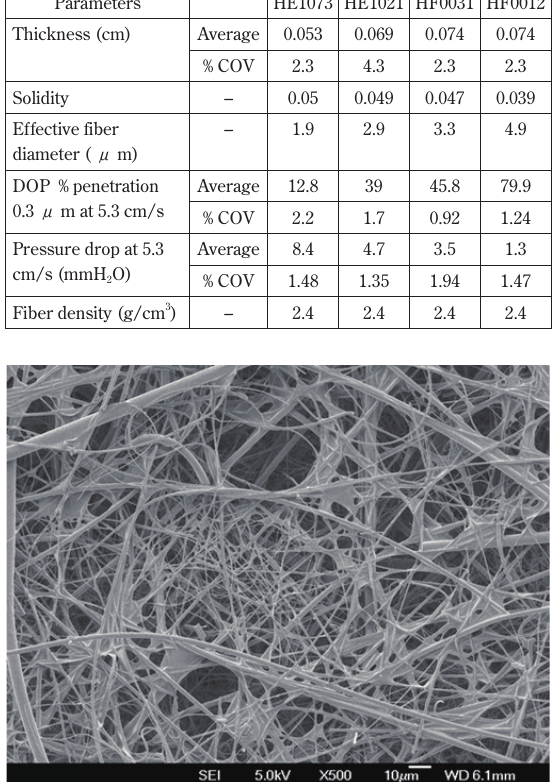
Fig. 4 SEM image of HE 1073 filter.